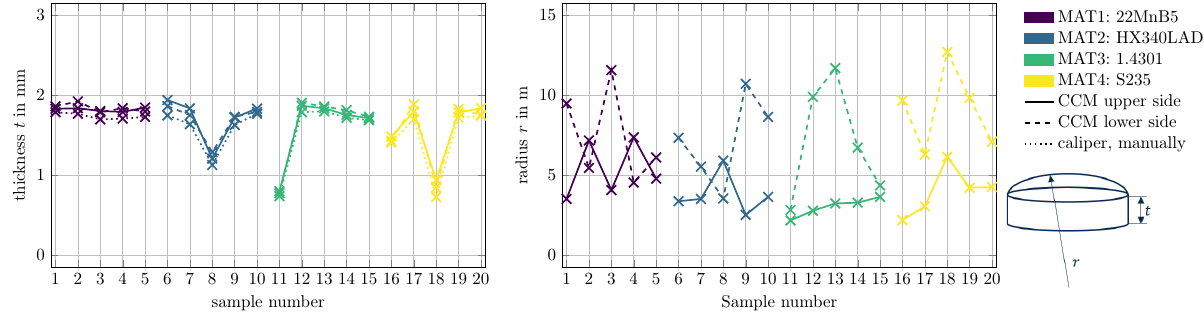
Figure 10. Thickness t of each disc-sample measured by CCM and manually by means of a caliper ( left ) and spherical radius r to evaluate the surface flatness after the preparation of the samples ( right ).